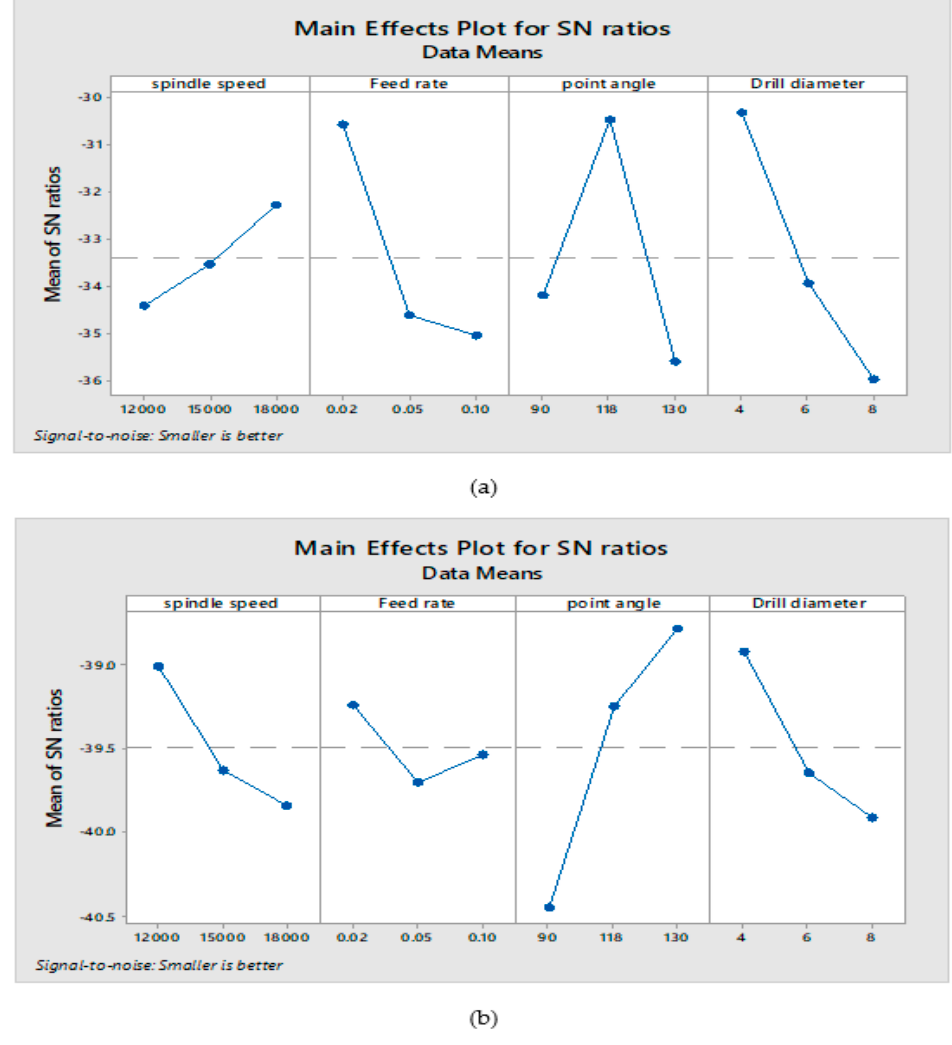
Figure 3. Main-effects plots for S/N ratios of ( a ) Thrust force and ( b ) Temperature. With an increase in point angle, temperature was observed to drop. The figure clearly shows that the tool’s temperature rose as drill diameter increased. The size of the contact area between the workpiece and the drill bit determines how much friction is generated during drilling [29]. The contact surface increases with a larger drillbit diameter, causing higher friction. The tool’s temperature rises as a result of more intense heat generation during drilling. The combination of spindle speed level 3 (20,000 rpm), feed rate level 1 (0.02 mm/rev), point angle level 1 (90°) and drill diameter level 3 (6 mm) produced the highest temperature of 142 °C. This is closer to the temperature at which glass transitions occur,